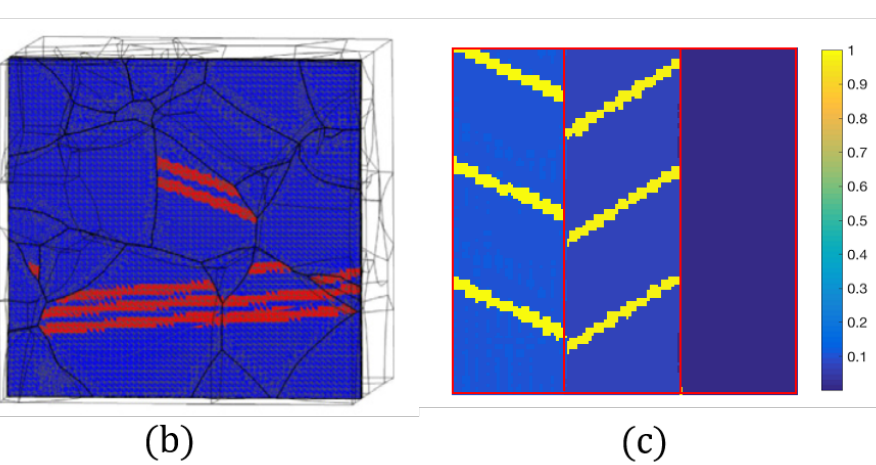
Figure 21. Site–specific twin nucleation efforts using ( a ) probabilistic methods, date form [201], ( b ) dissociation energy-based twin nucleation method, data from [205], and ( c ) characteristic twin spacing as a function of twin